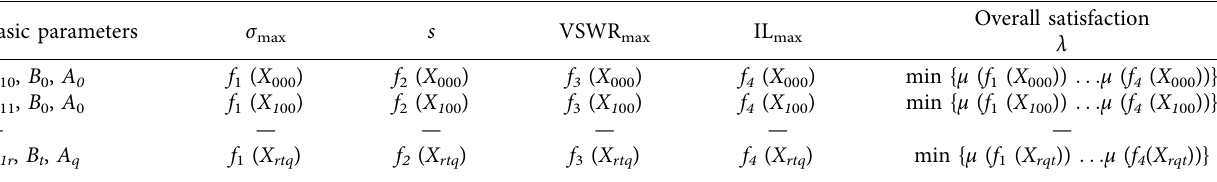
Table 2: Satisfaction of each objective parameter after